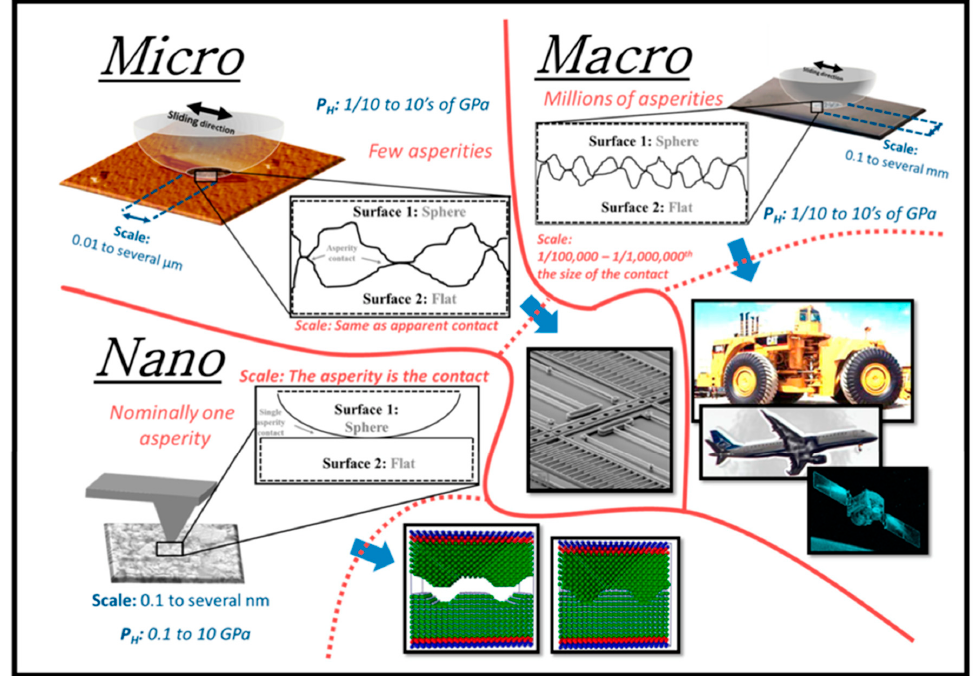
Figure 10. Different length scale (i.e., macro, micro, and nano) investigations used in tribology [127]. This figure is taken from Reference [127] with permission from the